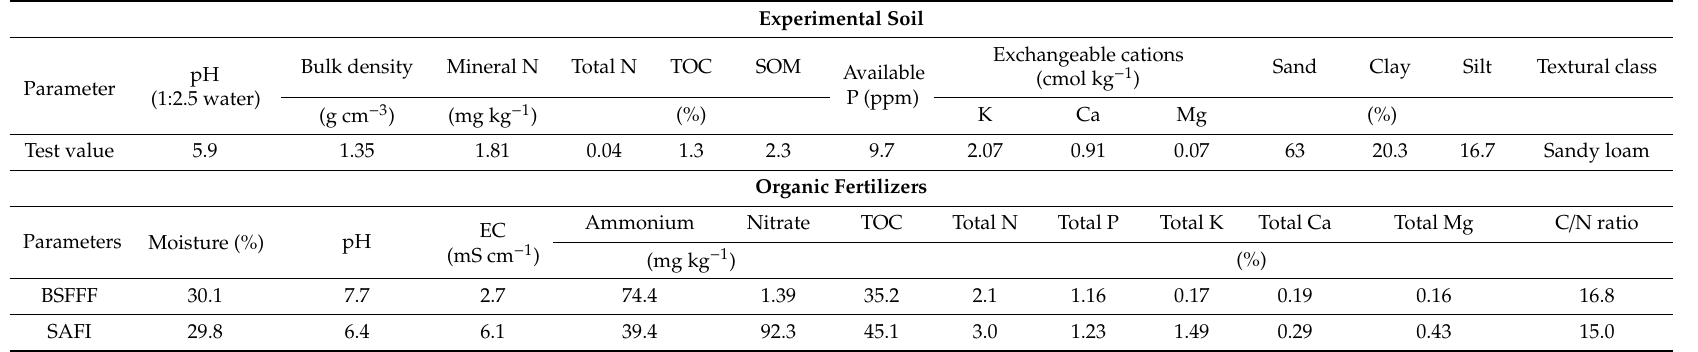
Table 1. Selected physical and chemical characteristics of the experimental soil, and organic fertilizers. Experimental